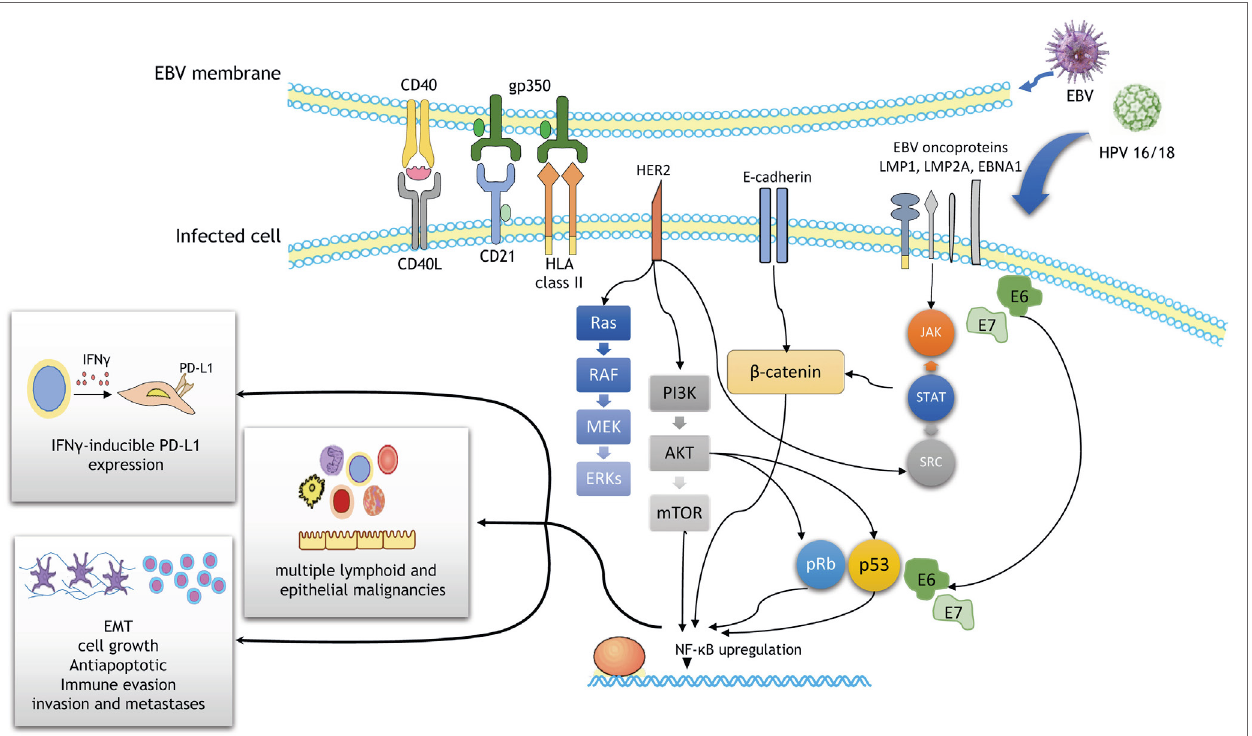
FigURe 1 | Schematic outline showing a potential cooperation between Epstein–Barr virus (EBV) and human papilloma virus (HPV) oncoproteins to initiate cancer development and enhance malignancy progression. Efficient infection involves the activation of the PI3K/AKT, MAPK/ERK, JAK/STAT, β -catenin, and p53 pathways. As a result, NF- ĸ B upregulation induces cell proliferation, epithelial–mesenchymal transition (EMT), and immune evasion through IFN γ -inducible PD-L1 expression.